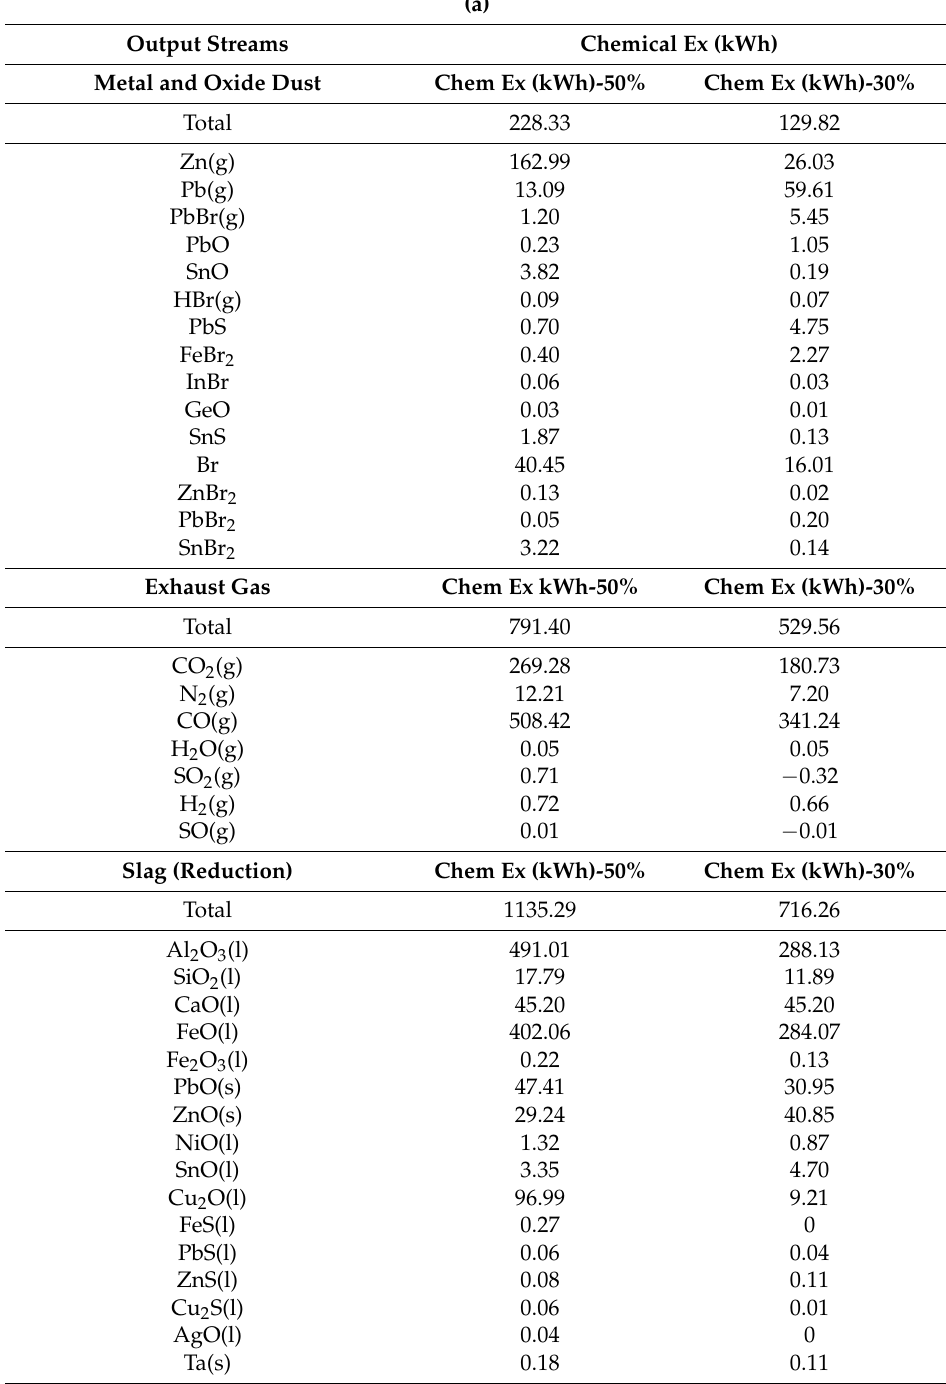
Table 9. Exergy values of materials going out of reduction (a), oxidation (b), fire refining (c), and electrorefining (d) furnace on a chemical component